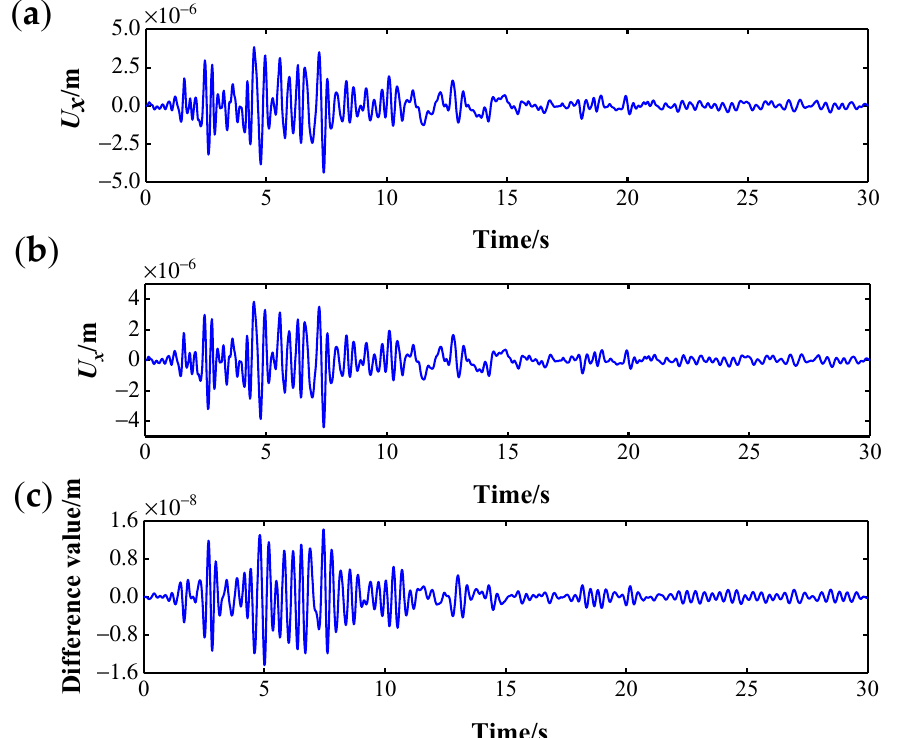
Figure 6. Displacement response of No. 64 measurement point: ( a ) scenario 1; ( b ) scenario 2; ( c ) the response difference.